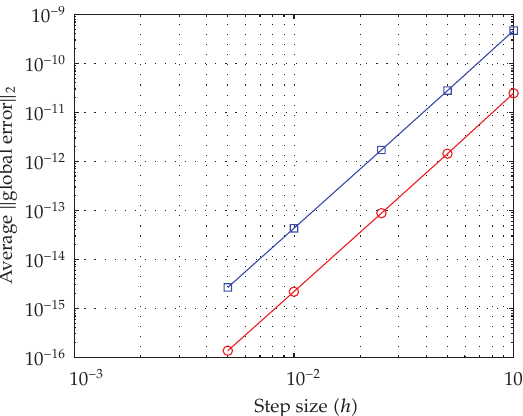
Figure 11: Comparison of the accuracy of the ARK4 (cid:4) blue (cid:5) and TSRK4 (cid:4) red (cid:5) methods in solving IVP-1.